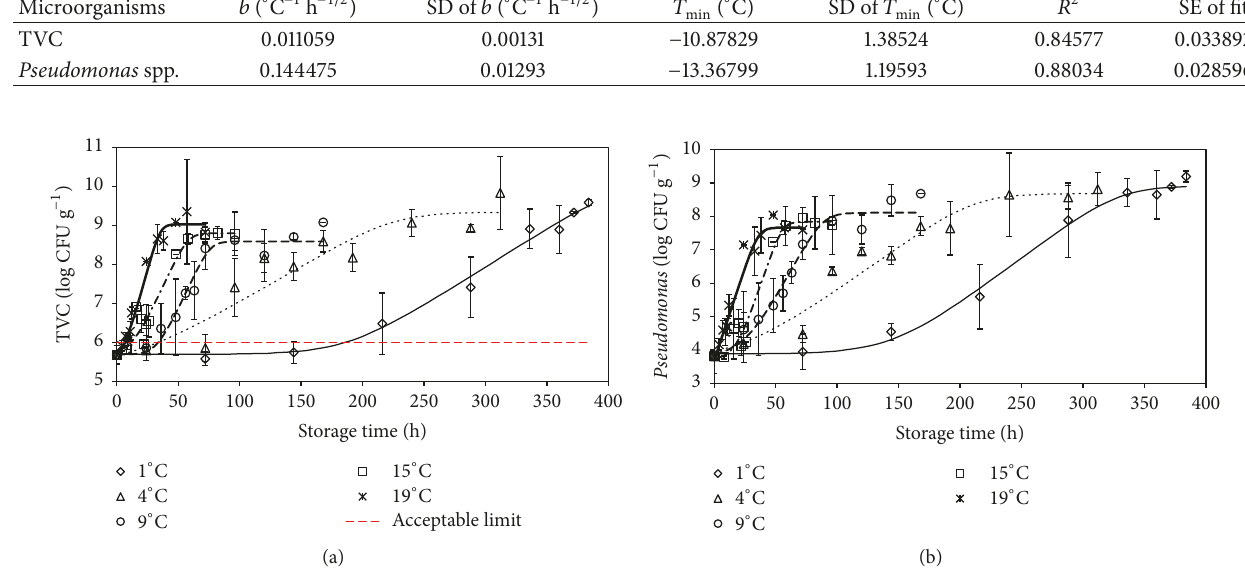
Figure 3: Changes in (a) TVC and (b) Pseudomonas counts of Pangasius fillets during storage at stable temperatures, with observed values (markers) and fitting curves (lines) using primary Baranyi and Roberts